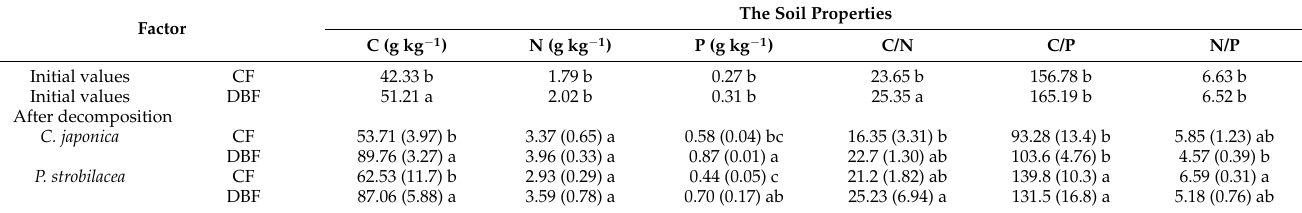
Table 3. The soil properties ( n = 3. means ± 1 se) under the CWD of the two tree types ( C. japonica vs. P. strobilacea ) in the two habitats (CF vs. DBF) after decomposition. Different lowercase letters indicate significant differences ( p < 0.05). CF: coniferous forest; DBF: deciduous broadleaf